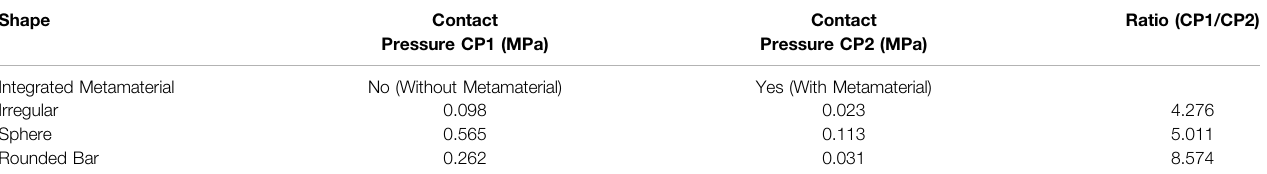
TABLE 2 | Contact pressure between the soft fi nger and the grasped shapes without and with the integrated metamaterial.